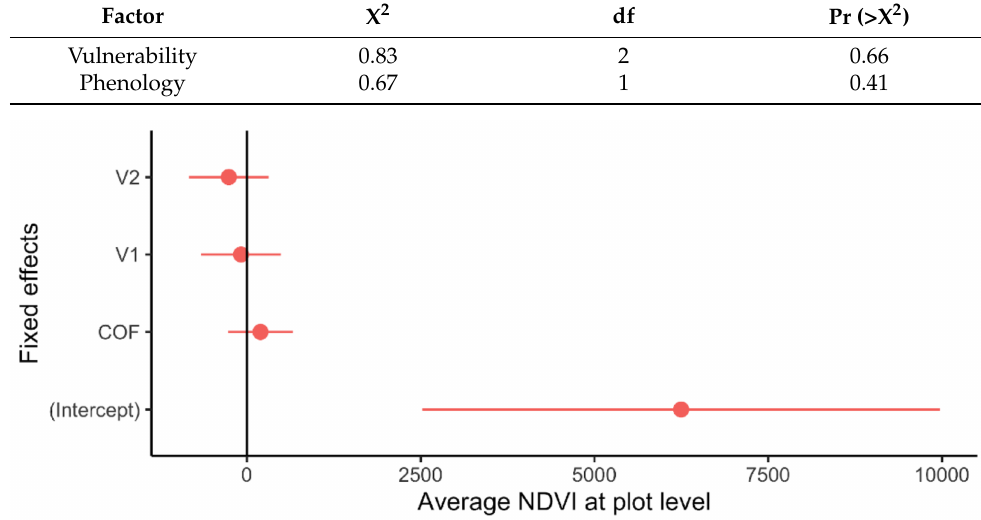
Figure 5. Model 1: coefficients and confidence intervals of fixed effects during year 1. Fixed effects include Vulnerability (V0, V1, V2 levels) and Practice (APF, COF levels). Contrasts were level V0 for the Vulnerability factor and COF for the Practice factor. Red colored effects are not significant at p < 0.001 level. Vulnerability and Practice did not significantly affect the average NDVI during cultivation year 1.